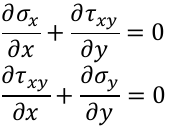
Fig. 1. Location of the region under consideration: (a) based on the cutting pattern and (b) in the plane of BXY , in which the pressure P is distributed. ARB is the absolutely rigid body, the angle 2β 0 = ε (apex angle).